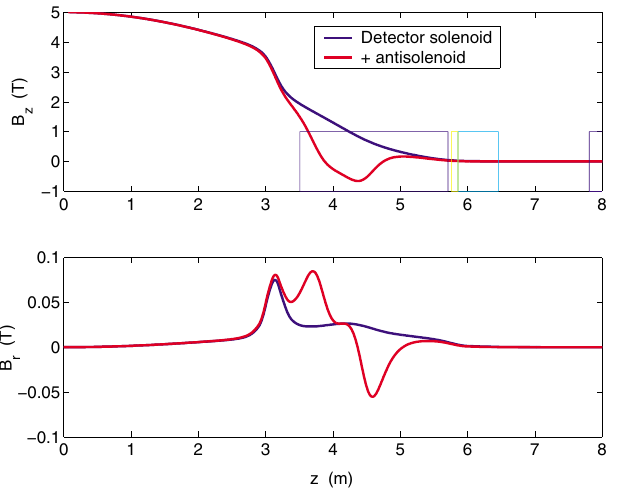
FIG. 13. (Color) Fields in SiD with and without the optimized weak antisolenoid. IP is at z (cid:3) 0 m .